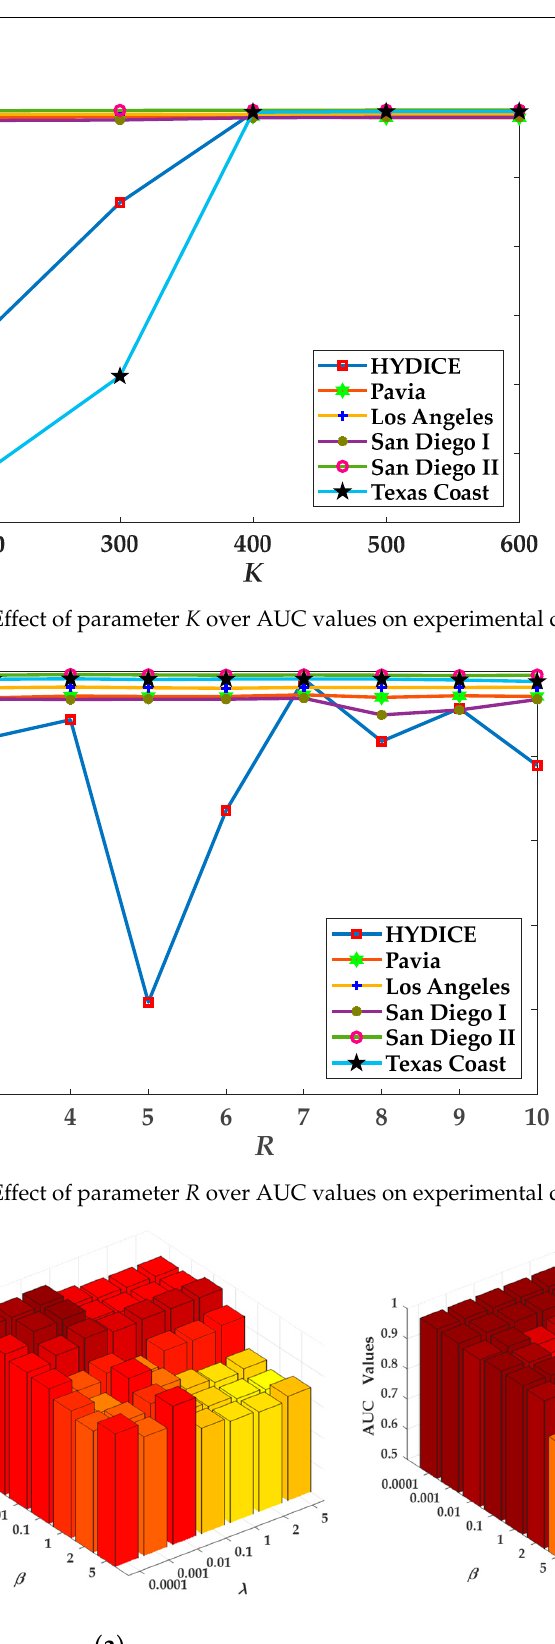
Figure 9. Effect of parameter λ and β on AUC values for proposed method on ( a ) Pavia and ( b ) Los Angeles. Table 1. Optimal parameters settings for experimental datasets.